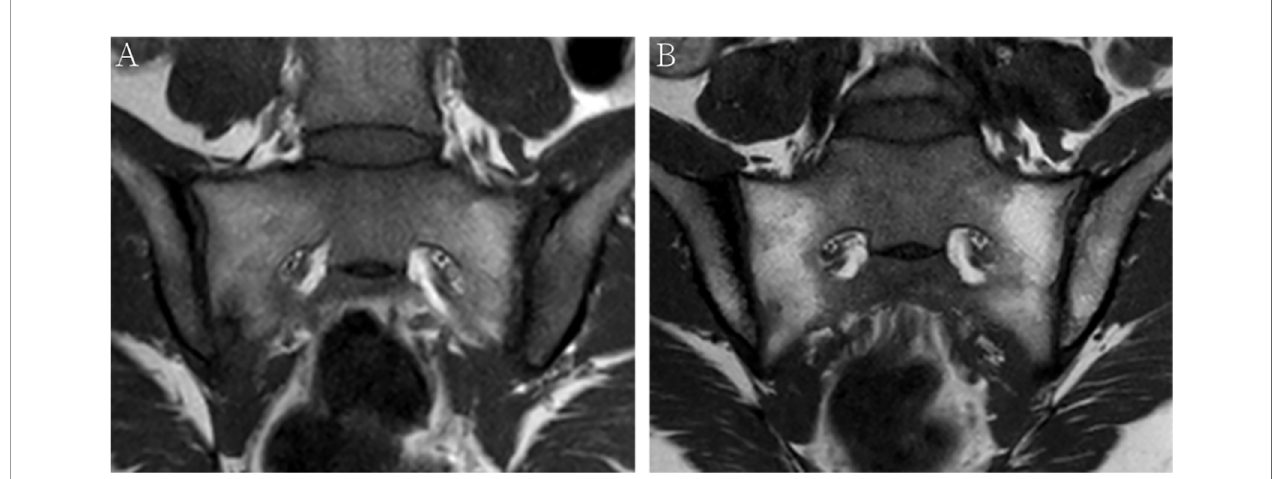
FIGURE 3 | MRI fi ndings of a 38-year-old female with HLA-B27 negative axial spondyloarthritis at baseline (A) and 12-month follow-up (B) . Coronal oblique T1 images show fat metaplasia at both sacroiliac joint surfaces, however, no back fi ll occurs after 12-month